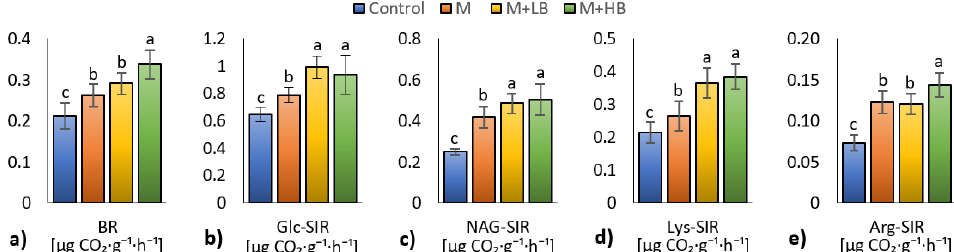
Figure 2. Mean values of soil basal (BR) and substrate induced (SIR) respirations. ( a ) BR = basal respiration, ( b ) Glc-SIR = respiration induced by D -glucose, ( c ) NAG-SIR = respiration induced by N -acetyl- β - D -glucosamine, ( d ) Lys-SIR = respiration induced by L -lysine, ( e ) Arg-SIR = respiration induced by L -arginine. Average values of independent replicates ( n = 3), error bars = standard deviation; the different letters express the statistical differences at significance level p ≤ 0.05.